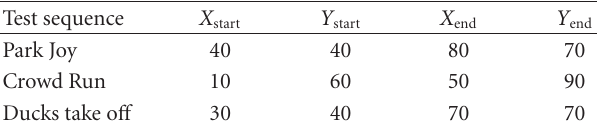
Table 2: Location of ROIs in the test sequences.